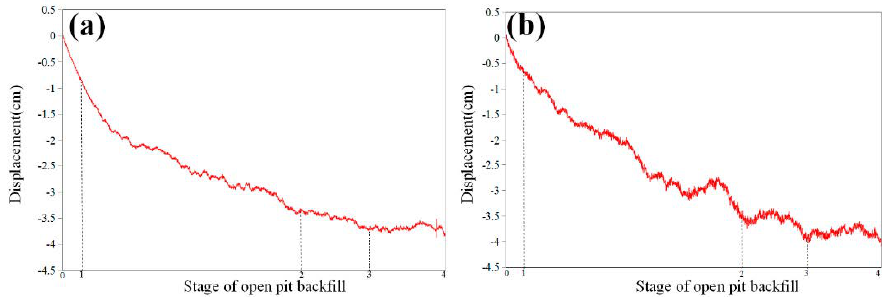
Figure 10. Displacements of measuring point 6 in the vertical ( a ) and horizontal ( b )